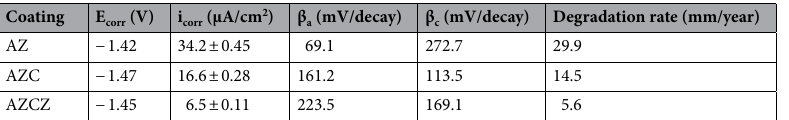
Table 3. Effect of surface modification on the degradation rate of AZ91 alloy in SBF at 37 °C.